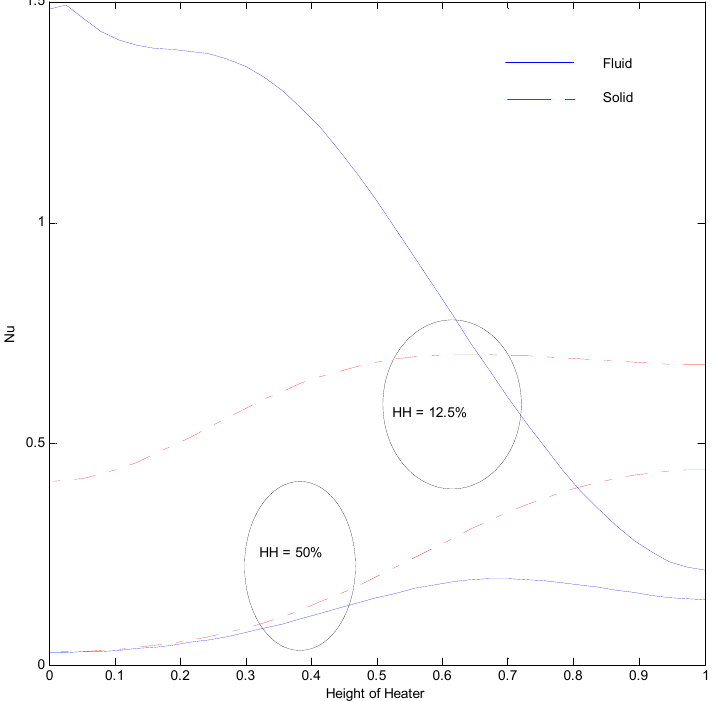
Figure 26. Nusselt number of left vertical surface at Ra = 100 , H = 5 , Kr = 1 , Rd = 0 for strip at